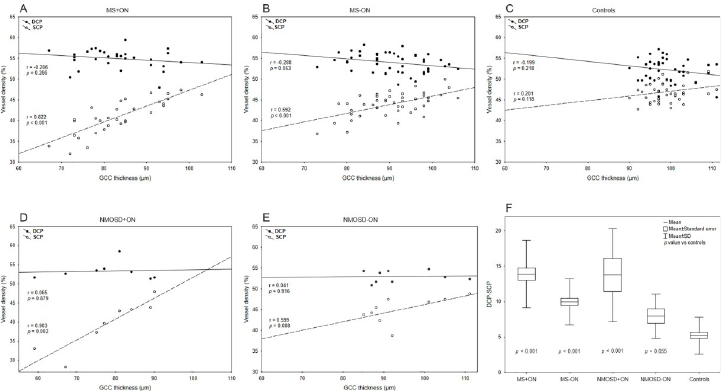
Fig 2. Graphical presentation of spectral-domain OCT and OCT angiography results. Scatter plots illustrating the linear association between GCC thickness and vessel density of SCP and DCP in patients and controls (A-E). The box plot presents the discrepancy between DCP and SCP of all groups (F). DCP , deep capillary plexus; GCC , ganglion cell complex; OCT , optical coherence tomography; SCP , superficial capillary